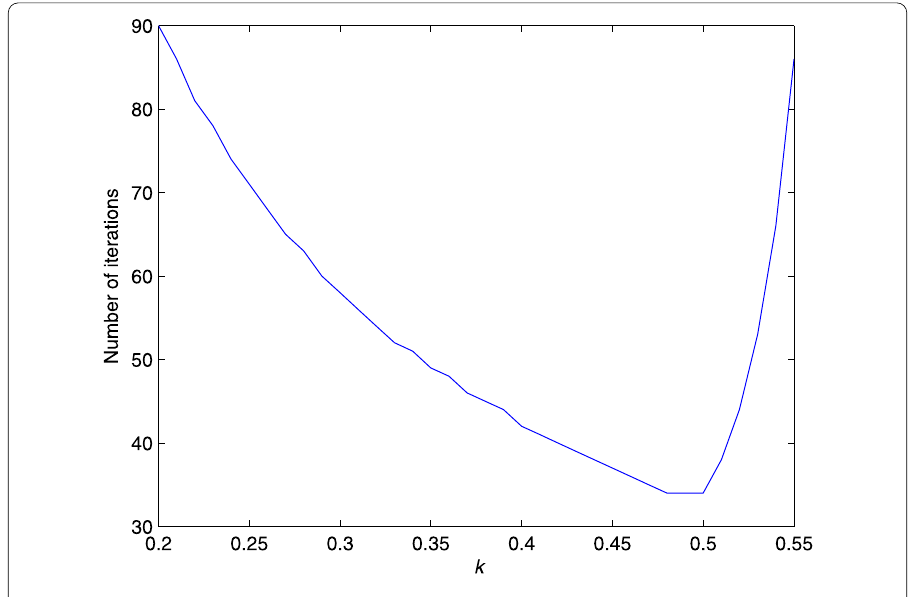
Figure 1 Sensitivity test on the step size